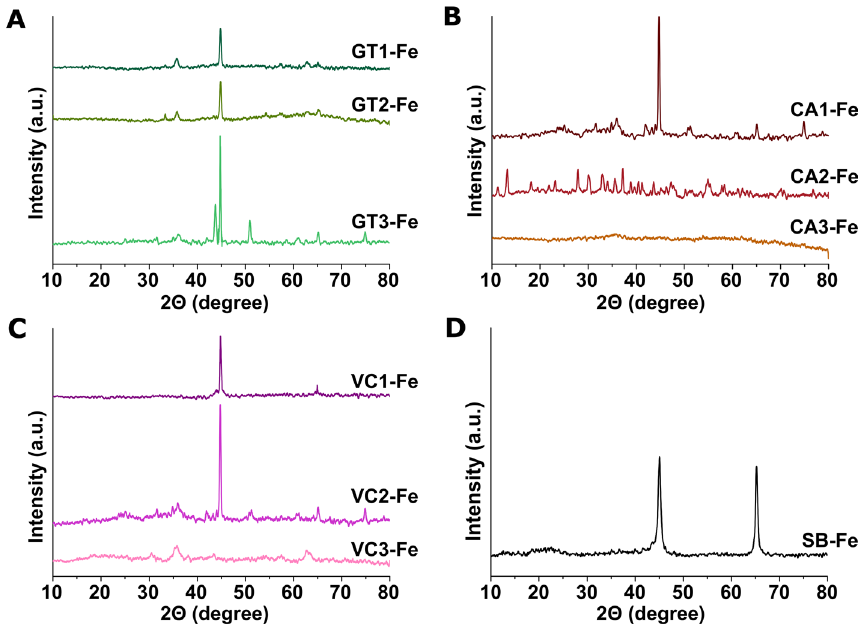
Fig. 2 X-ray diffraction patterns of iron nanoparticles produced by using various green waste extracts obtained in multiple extraction rounds. Iron nanoparticles were synthesized by three recycling extraction rounds of green tea extracts (GT1-Fe, GT2-Fe, and GT3-Fe) ( A ), cof- fee (CA1-Fe, CA2-Fe, and CA3-Fe) ( B ), Virginia creeper (VC1-Fe, VC2-Fe, and VC3-Fe) ( C ), and by chemical method using sodium borohydride (SB-Fe) ( D